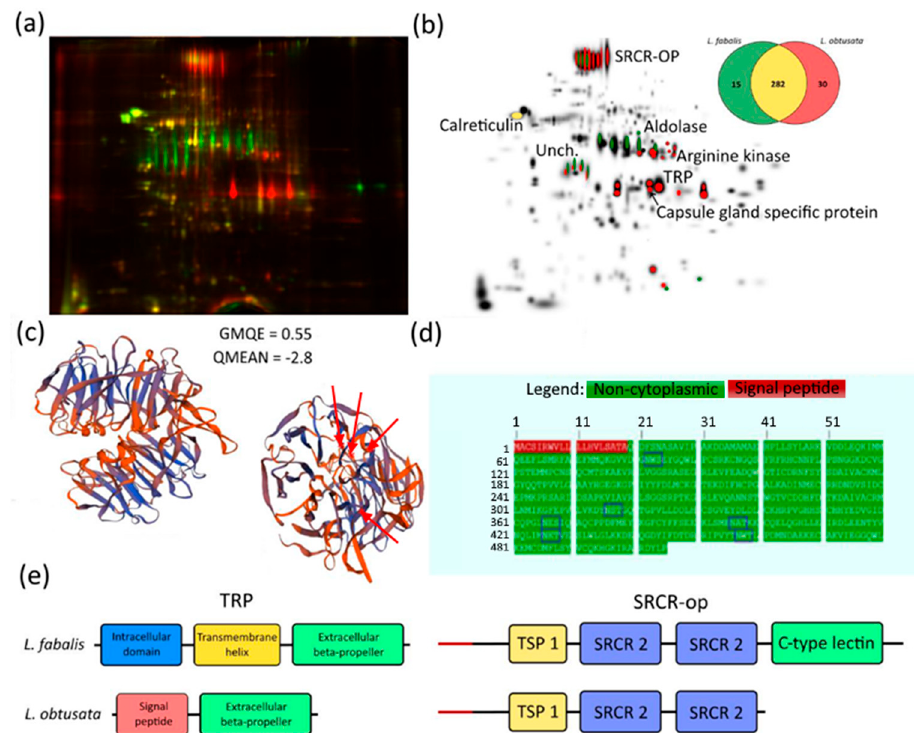
Figure 2. Results of proteomic analysis of L. obtusata and L. fabalis oviducts. ( a ) 2D DIGE electrophoregram with Cy3 and Cy5 channels merged; green—protein spots of L. fabalis oviducts, red—protein spots of L. obtusata oviducts. ( b ) PDQuest generated master-gel of all biological and technical replicates; green— L. fabalis species-specific spots, red— L. obtusata species-specific spots, names—proteins identified by MS/MS and discussed further; Unch.—“uncharacterized protein”; Venn diagram represents numbers of matched and species-specific proteins in proteomes of L. fabalis or L. obtusata oviducts. ( c ) Littorina obtusata Tachylectin-related protein (LoTRP) extracellular domain structure prediction results. The model in Protein Data Bank format provided in the full Western Blot in Supplementary. Protein 3D model was obtained by SWISS-model service [34]; red arrows—species-specific aa substitutions in the beta-sheets of one of the beta-propellers; GMQE and QMEAN Z-scores represent the quality of the obtained model. ( d ) Scavenger receptor cysteine-rich domain-contained oviduct protein (SRCR-OP) structure prediction results by Philius transmembrane prediction service [35]. Blue frames—N-glycosylation sites predicted by NetNGlyc 1.0 Server [36]. ( e ) Block diagram, representing a comparison of the domain structure of TRP and SRCR-OP from L. obtusata and L. fabalis .